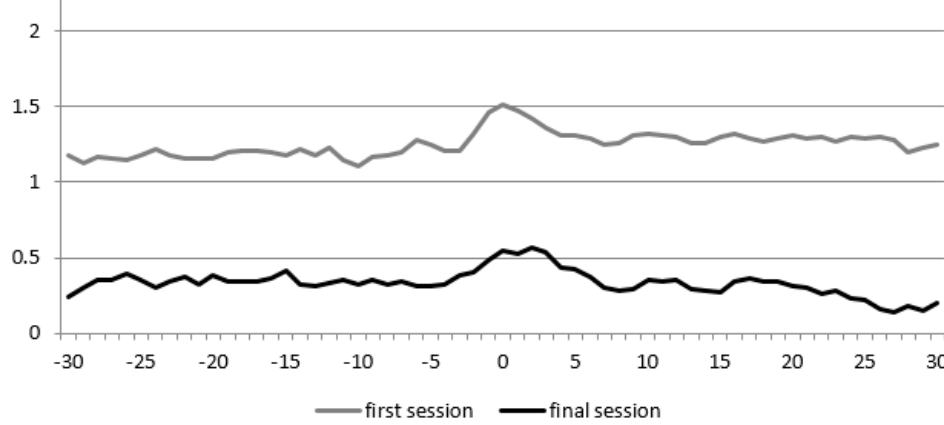
Figure 6. Diagonal Cross-Recurrence Profile (DCRP) of participant 5. The X-axis displays the delay in steps of 0.5 s, and the Y-axis the recurrence rate (the proportion of accurate turn-taking).